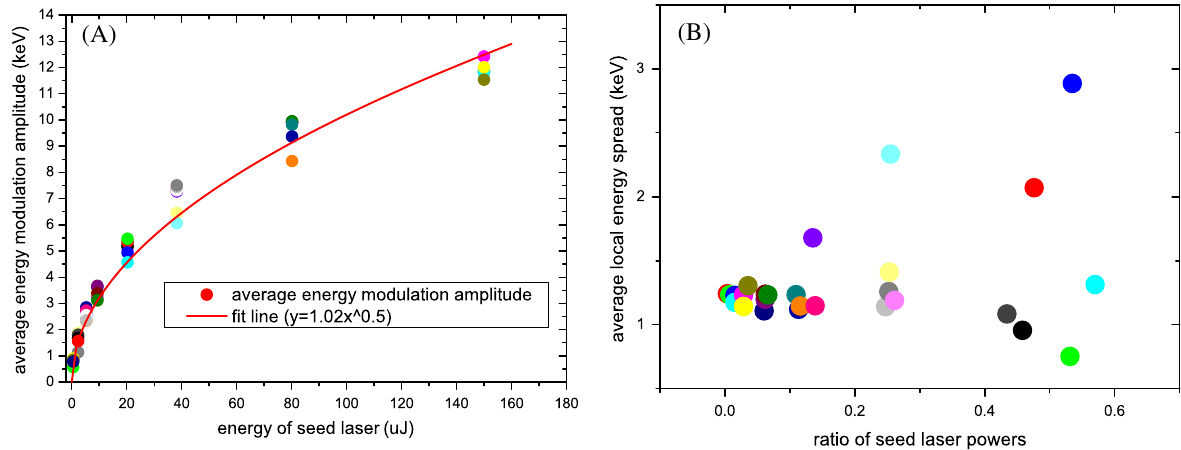
FIG. 10. Calculation results for all the combinations of experimental curves according to Eq. (12). (A) Average energy modulation amplitudes for various seed laser energies and the fitted curve of these points. (B) Average local energy spreads for various ratios of seed laser